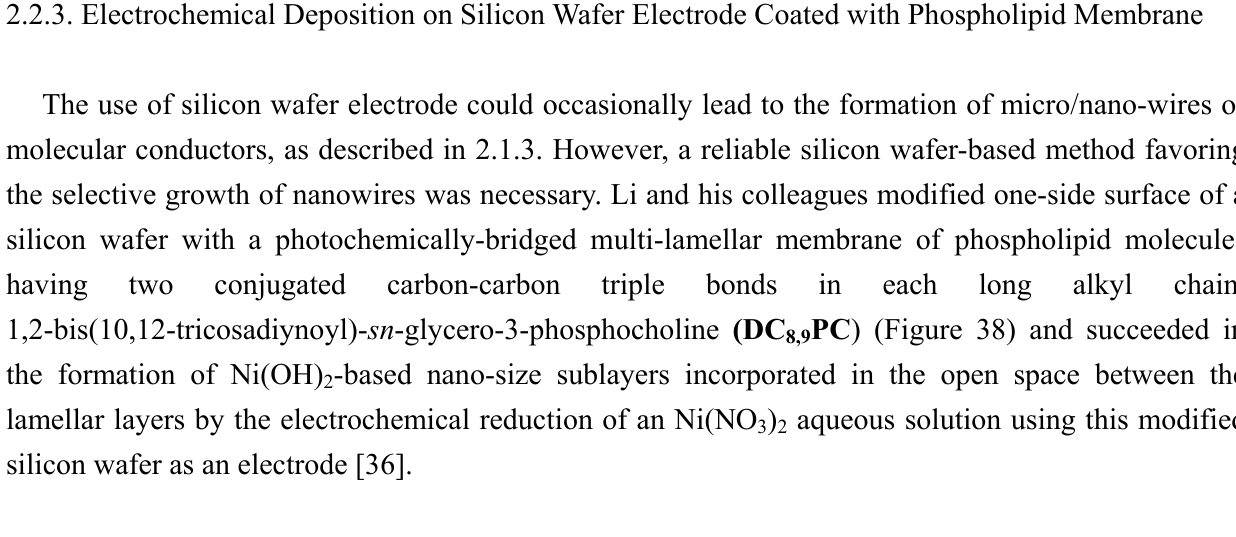
38. The chemical structure of 1,2-bis(10,12-tricosadiynoyl)- sn -glycero- 3-phosphocholine ( DC PC ). 8,9